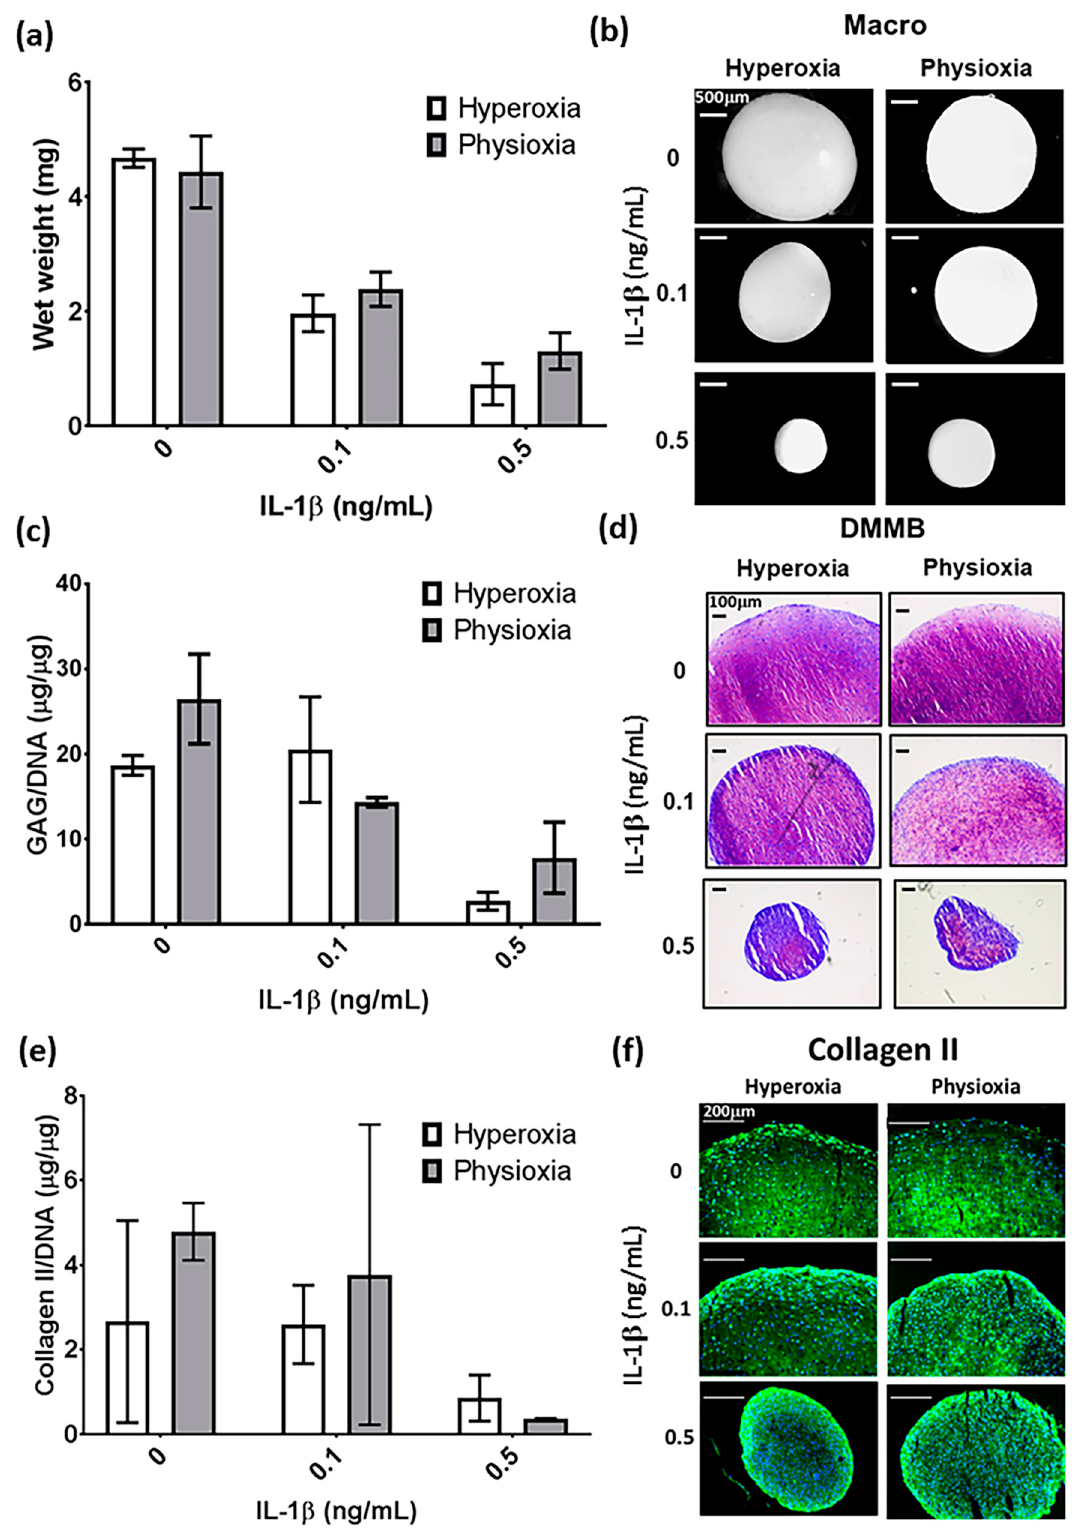
Figure 3. Pellet ( a ) wet weight, ( c ) GAG and ( e ) collagen II content in physioxia non-responsive donors in the presence of IL-1 β . Data represent mean ± S.E.M. of n = 2 donors. Representative ( b ) macroscopic, ( d ) DMMB and ( f ) collagen II-stained pellets of a non-responsive donor under physioxia and hyperoxia.